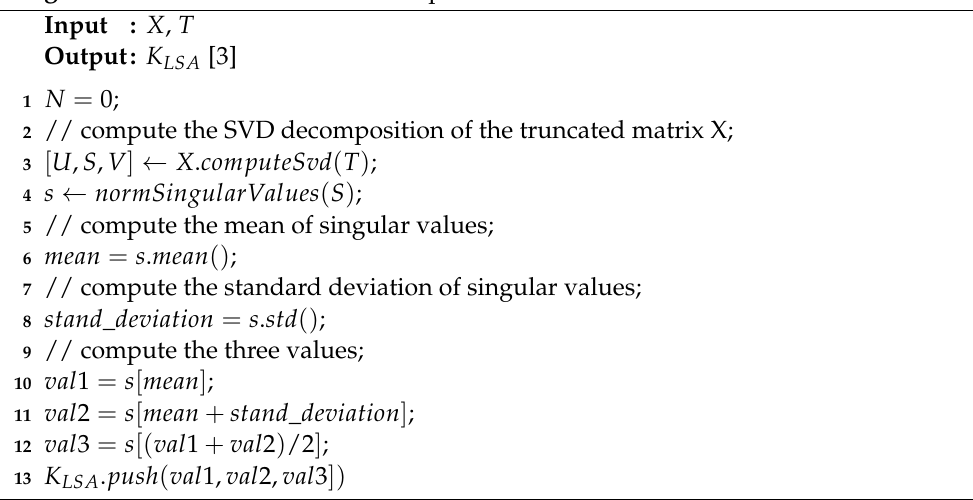
Algorithm 1: The enhanced ST-DaRe